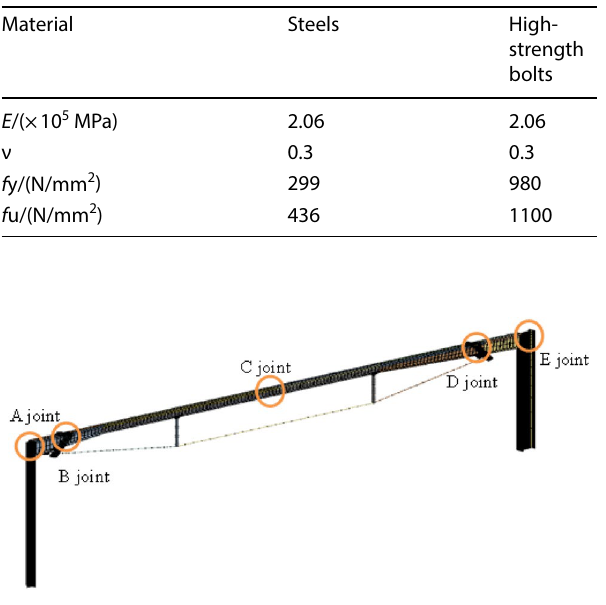
Fig. 7 Finite element model